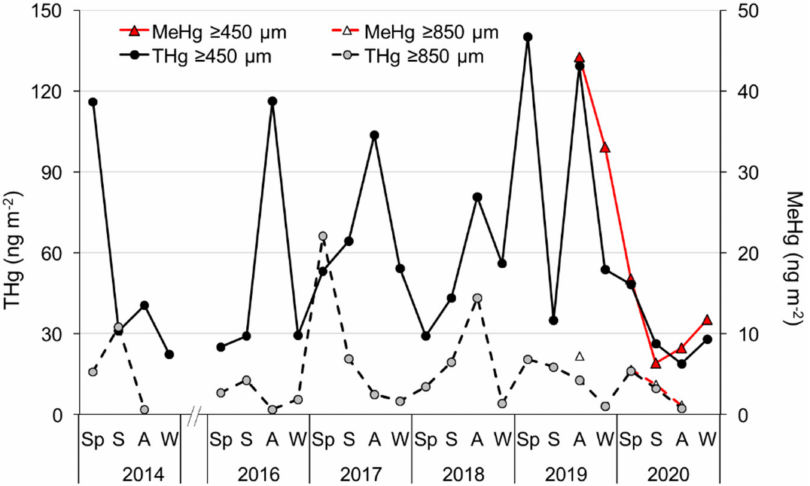
Figure 6. Mercury stock (as total mercury and methylmercury) in Lake Maggiore accumulated in zooplankton for two size fractions ( ≥ 450 µ m and ≥ 850 µ m) in different seasons of the investigated years (2014, 2016–2020). Sp = spring; S = summer; A = autumn; W =